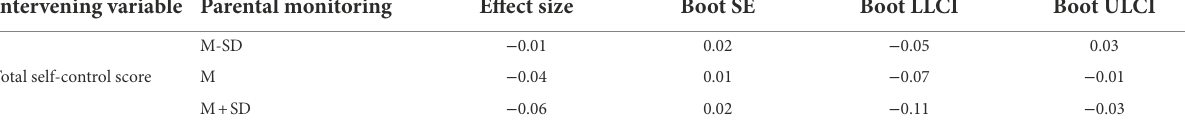
TABLE 5 The moderated mediating